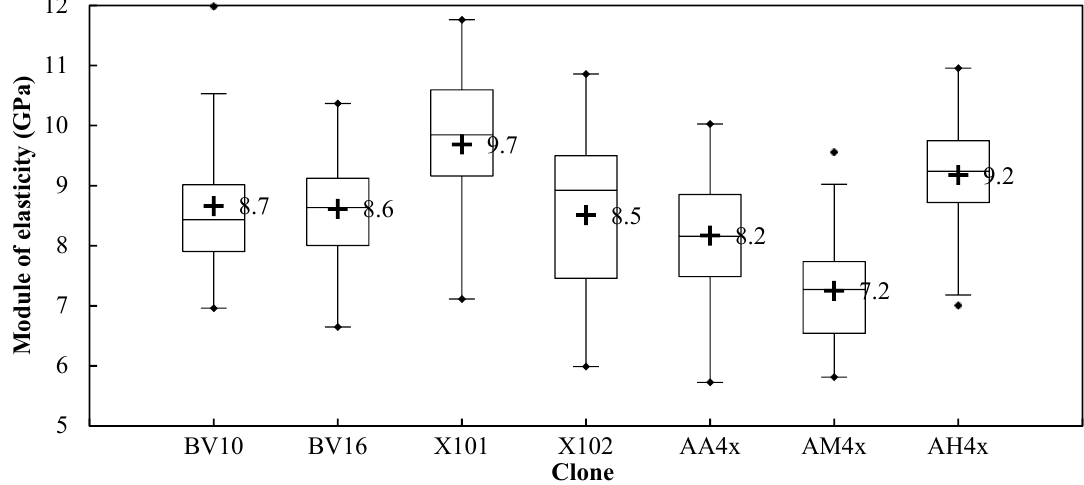
Figure 7. Variation of module of rupture (MPa).